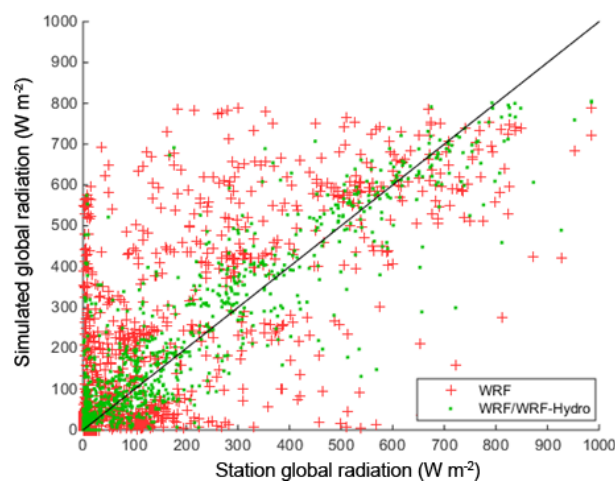
Figure 8. Scatterplot of global radiation from WRF and WRF– WRF-Hydro simulations versus station observations across the